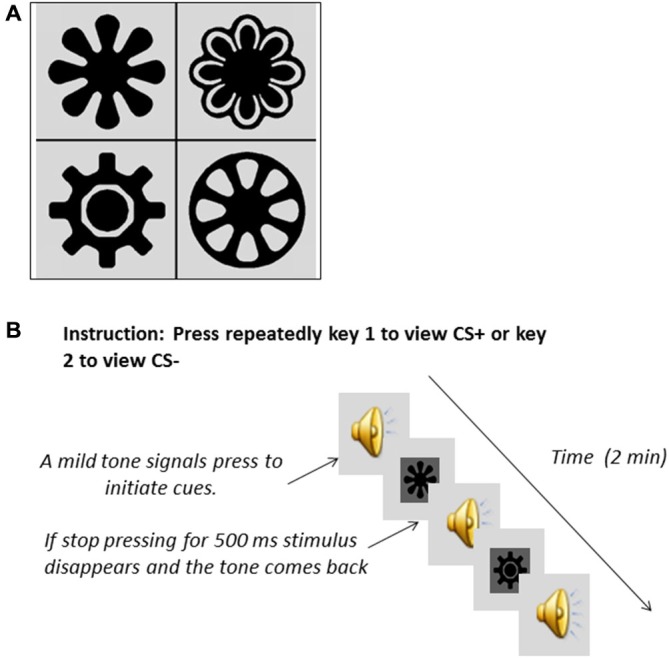
Visual stimuli (A) used during the Pavlovian conditioning for the participants to learn associations with either monetary reward (CS+) or with absence of reward (CS−). Description of CRf testing (B). Participants had to press repeatedly either the key associated with the CS+ or the key associated with the CS− presentation. A mild tone prompted them to start pressing if they wanted. Absence of pressing for a time window of 500 ms made the stimulus disappear.